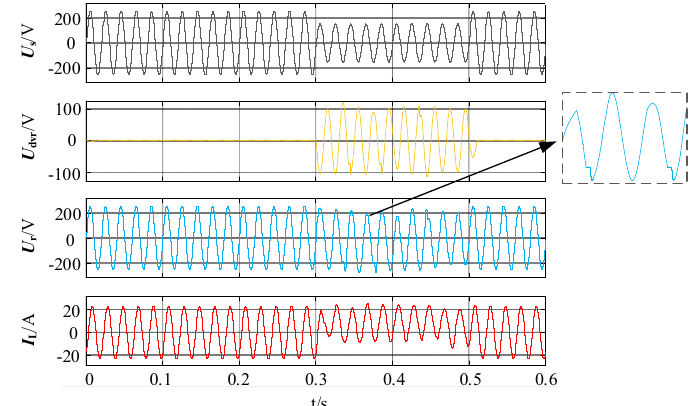
Figure 11. Energy minimized compensation simulation results.